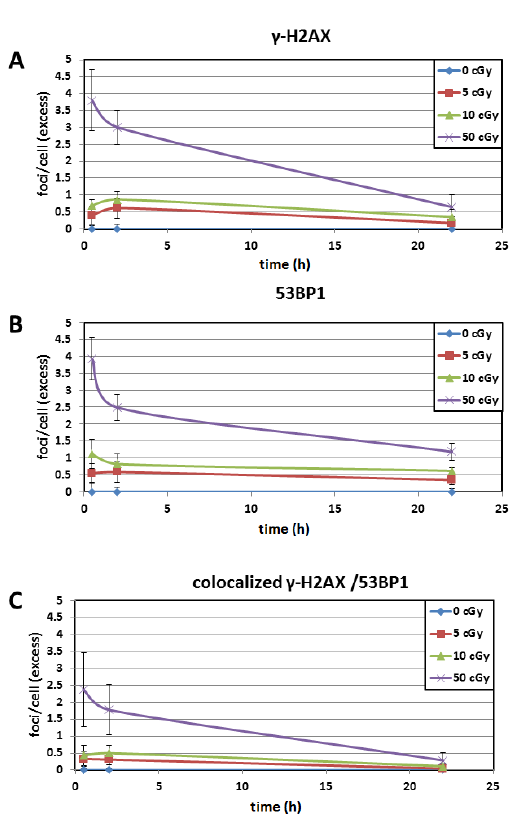
Figure 5. Time kinetics of IRIF. DNA repair foci were measured with: ( A ) γ H2AX, ( B ) 53BP1, and ( C ) co-localized γ H2AX / 53BP1 after irradiation with doses of 0, 5, 10, and 50 cGy. Data show the highest levels at 30 min for: ( A ) γ H2AX foci at all doses; ( B ) 53BP1 and ( C ) co-localized γ H2AX /